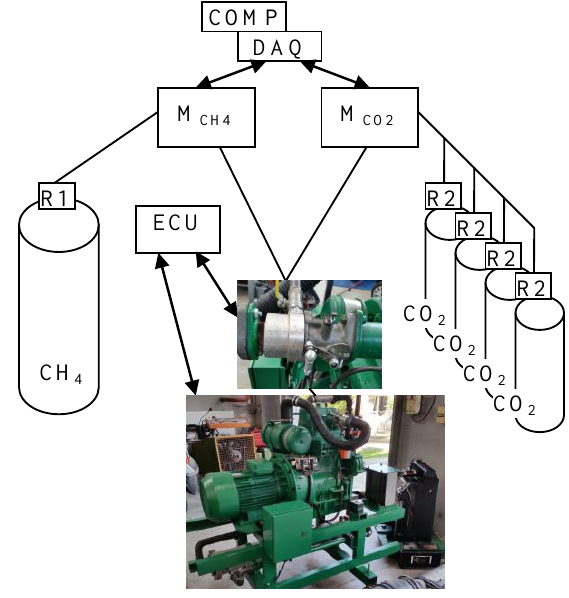
Fig. 3. Diagram of the engine's fuel supply